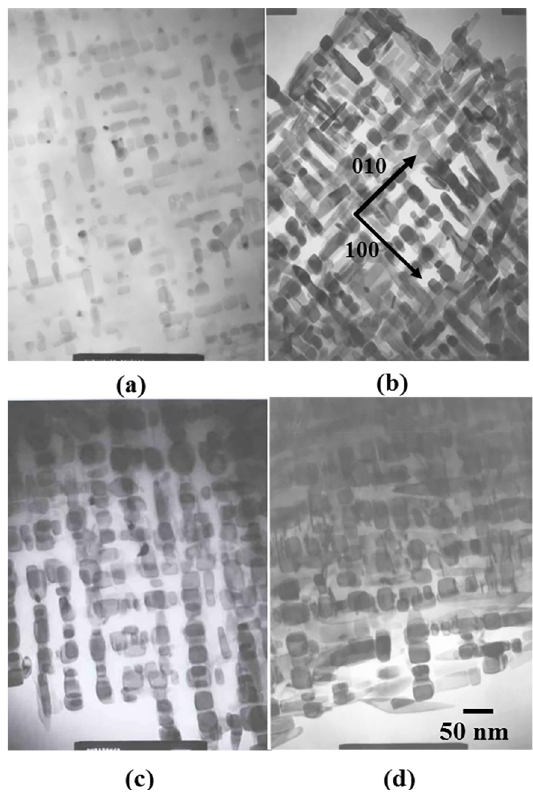
Figure 2. BF-TEM micrographs of Cu-4wt.%Ti alloy aged at 500 °C for (a) 0.0166 h, (b) 0.5 h, (c) 1 and (d) 5